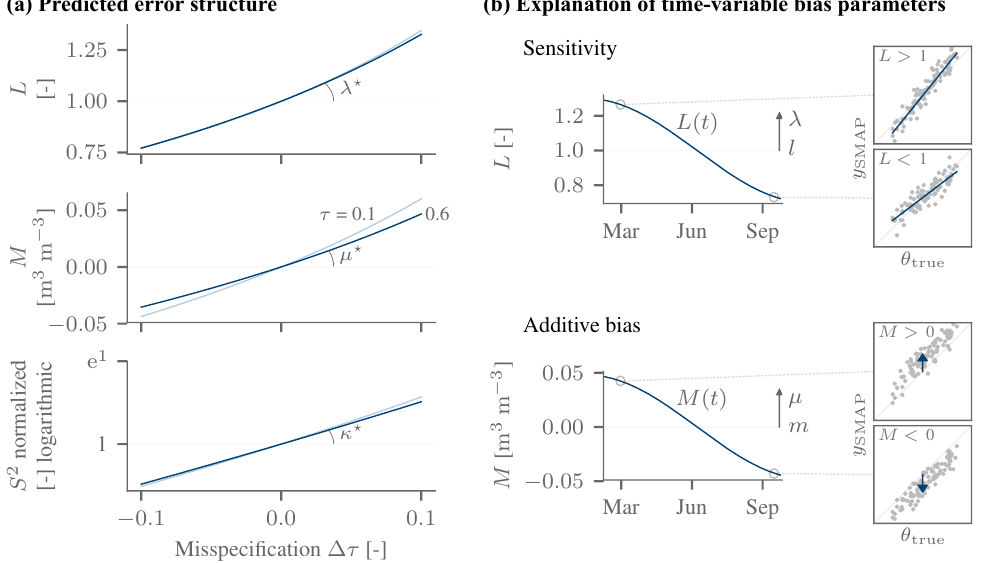
Figure 3. (a) The expected error structure due to a misspecified vegetation in the SMAP retrieval. Additive bias M , sensitivity L and variable noise level S 2 induced by a misspecified vegetation optical depth τ , as predicted by the τ − ω model for the SMAP satellite and single- scattering albedo ω = 0 . 05. Two different values of the true τ were assumed (0.06 in dark blue, 0.01 in light blue). The slopes of these approximately linear relationships will later be compared to independent data-driven estimates. (b) General explanation of the bias terms, illustrated for a hypothetical time-changing sensitivity L(t) and offset M(t) (underlying change in (cid:49)τ not shown). A varying sensitivity changes the response of the SMAP retrieval to a unit change in the true soil moisture. When it is larger than one, the SMAP data have a larger dynamic range than the true soil moisture (illustrated by the slope > 1 in the inset). The time-average value of L is l , and the temporal standard deviation of L is given by | λ | (length of arrow). A variable M induces non-constant offsets, and the magnitude of its temporal variability is given by | µ | . M > 0 corresponds to a positive offset (shown in the inset).